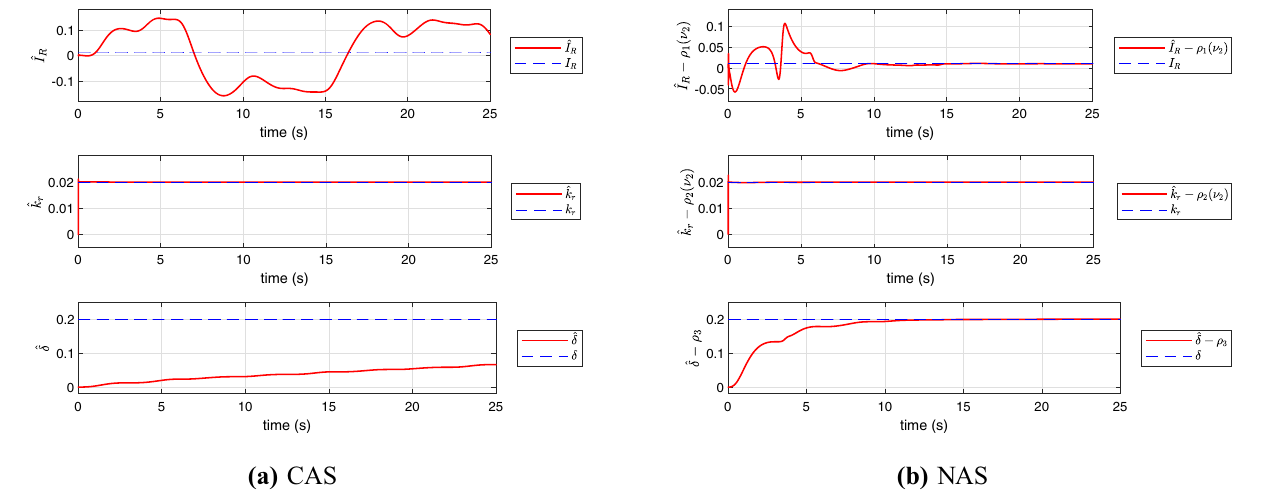
Figure 9. The state profile of the adaptive controller to handle uncertain parameters.